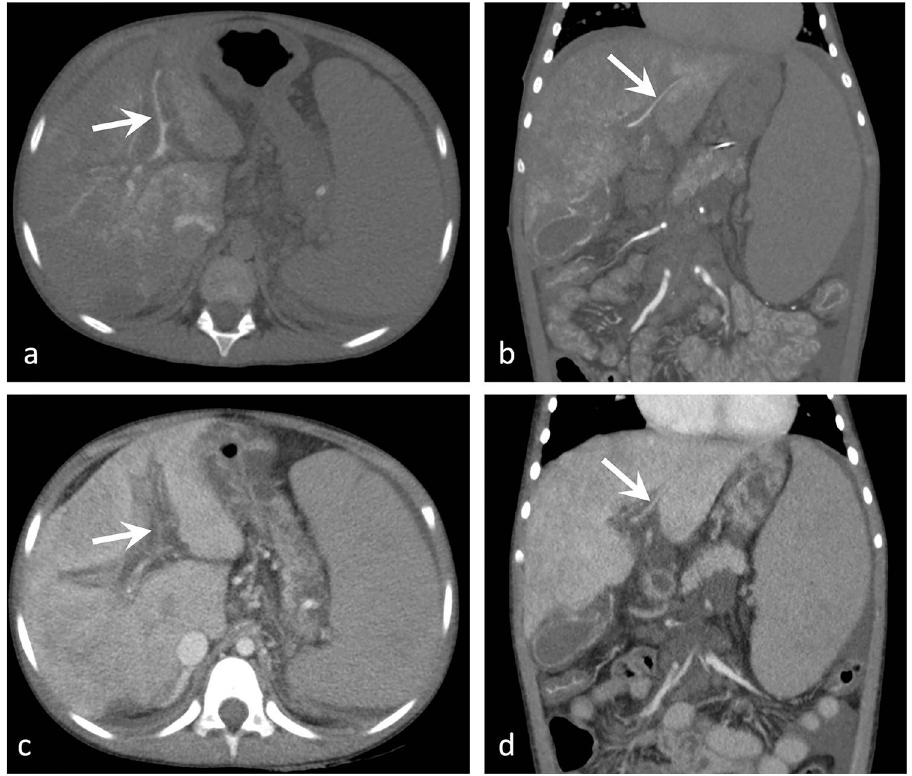
Figure 2. A 8-year-old female patient with PH. Coronal and axial images of CT-AP ( a , b ) and CE-CT ( c , d ). The left central and peripheral intrahepatic PV (arrows) were categorized "not reliably assessable" in CE-CT ( c , d ). CT-AP delineates the small, but clearly patent left intrahepatic PV.